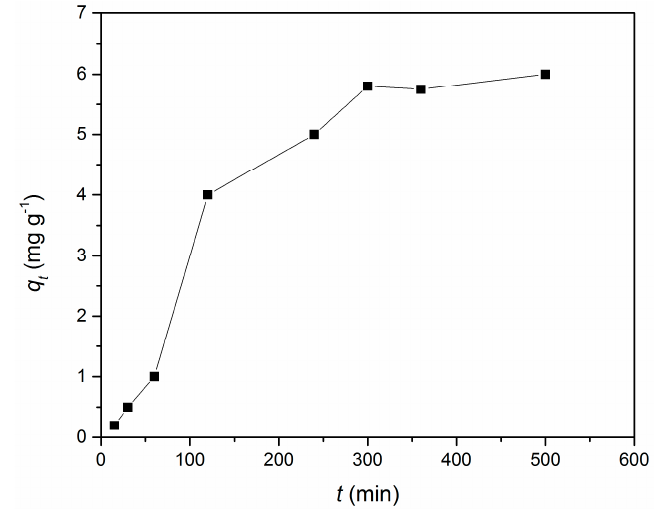
Figure 3. The effect of contact time onto Se(VI) adsorption using the ER/DETA/FO/FD; experimental conditions: c o = 1 mg L − 1 , temperature 22 °C, stirring speed 170 rpm, pH = 4, sorbent dose 0.16 g L − 1.